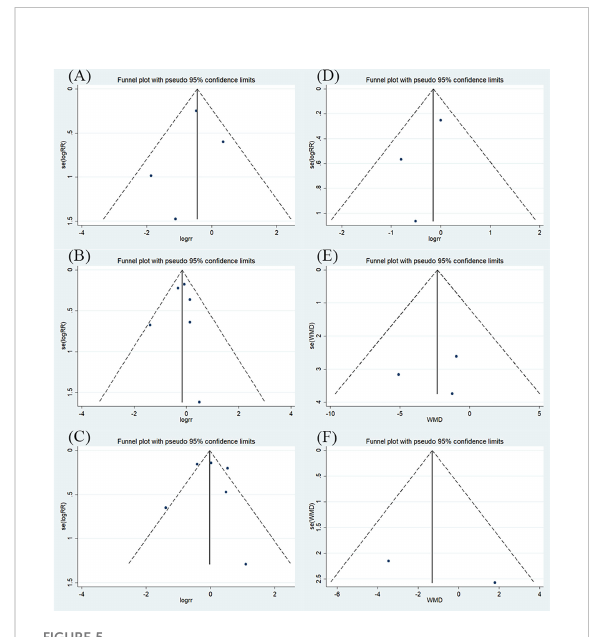
FIGURE 5 The results of funnel plot (A) mortality rate; (B) patients experiencing AEs and SAEs; (C) types of AEs and SAEs; (D) patients requiring respiratory support; (E) duration of oxygen therapy; (F) hospital